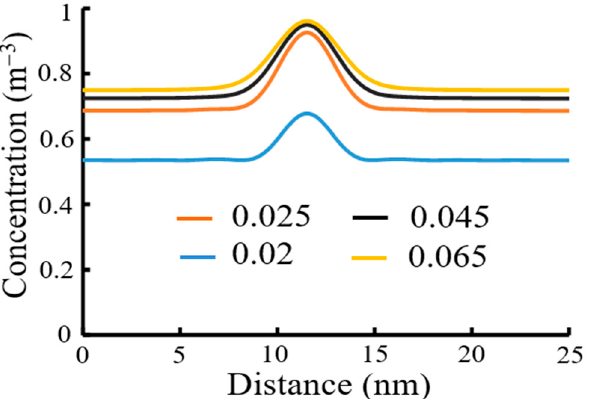
Figure 5. Simulation results for cross-linked polymer concentration of a negative CAR after PEB by